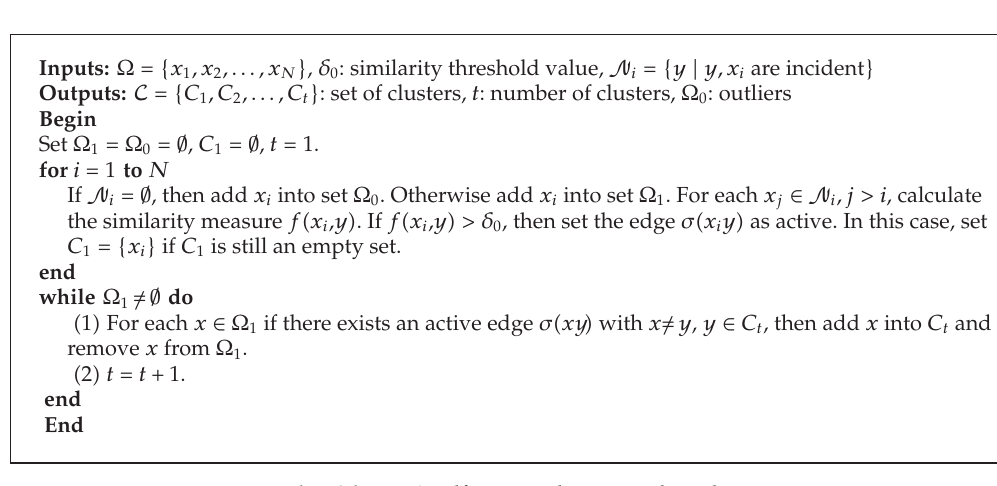
Algorithm 1: A self-joining clustering